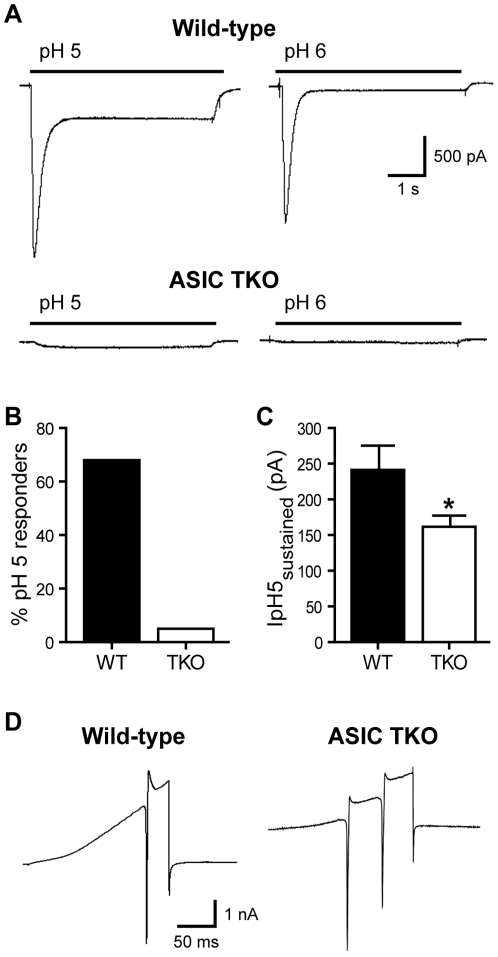

ASIC-like currents are absent from ASIC triple-knockout (TKO) DRG neurons.
A, Representative pH 5- and pH 6-evoked currents from wild-type (WT) and ASIC triple-knockout (TKO) DRG neurons. Note that transient acid-evoked currents were never seen from ASIC TKO neurons. B, Percentage of DRG neurons from WT and ASIC TKO mice that responded to pH 5 with a current amplitude > 250 pA (n  =  29 and 32, respectively). C, Mean sustained current amplitudes measured at the end of a 5 s pH application (as in Fig. 1A) for above cells. *p < 0.05 vs. WT by unpaired t-test. D, Voltage activated currents from WT and ASIC TKO mice evoked by ramping from −70 to +20mV in 200 ms.